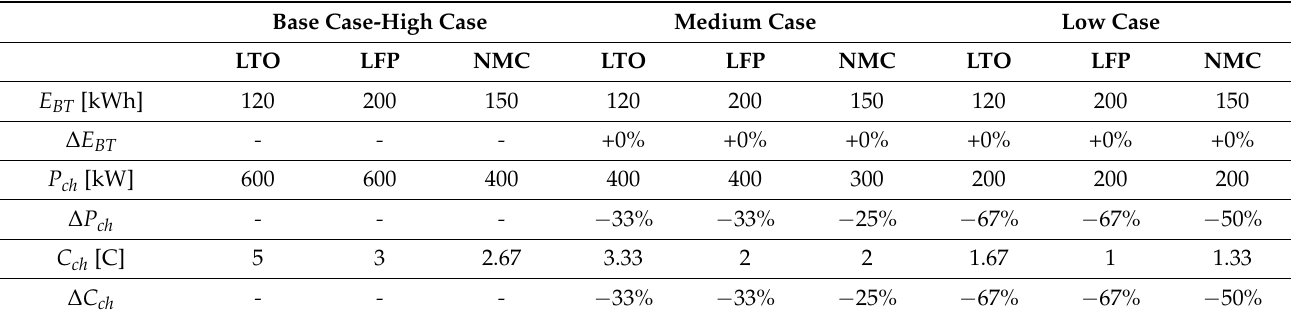
Table 6. Sensitivity analysis in relation to charger power.